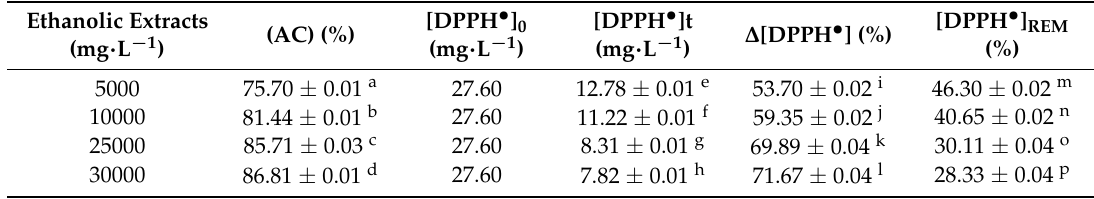
Table 2. Antioxidant capacity (%AC) and total phenolic content (TPC) of bee pollen ethanolic extracts. Ethanolic Extracts